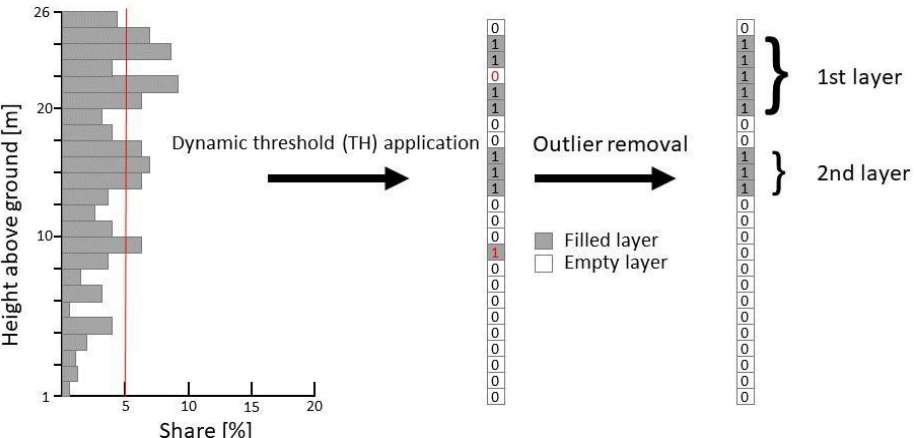
Figure 4. Processing steps to derive the NoLs from the relative frequency distribution of amplitude per 1 m height layer in the BDA. In the vector in the middle of this figure, isolated “filled” or “empty” layers marked in red colour are considered as outliers. These outliers are assigned the status of their adjacent height layers before calculating the NoLs.